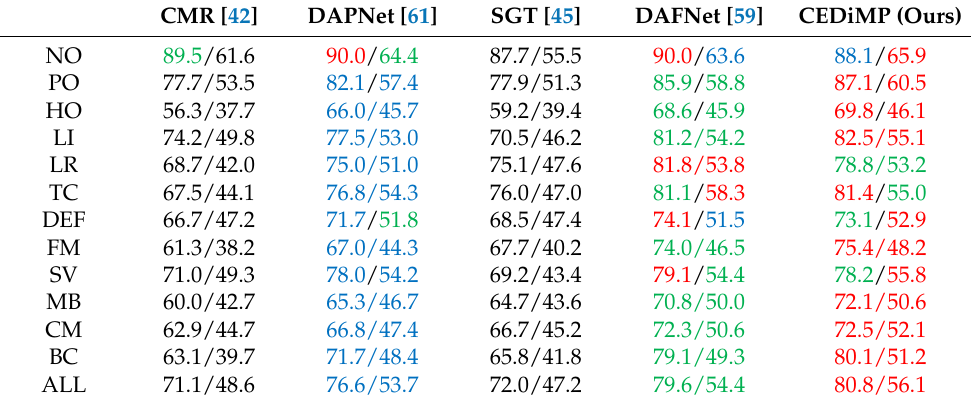
Table 3. PR/SR scores (%) based on attributes. The best, second, and third performances are shown in red, green, and blue,